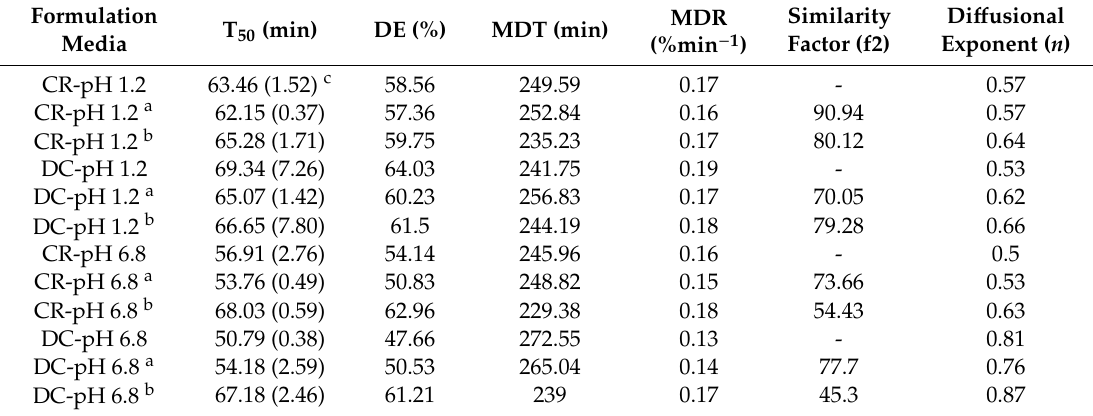
Table 2. Dissolution parameters and mechanism of drug release from CR and DC hypromellose compacts in various hydroalcoholic